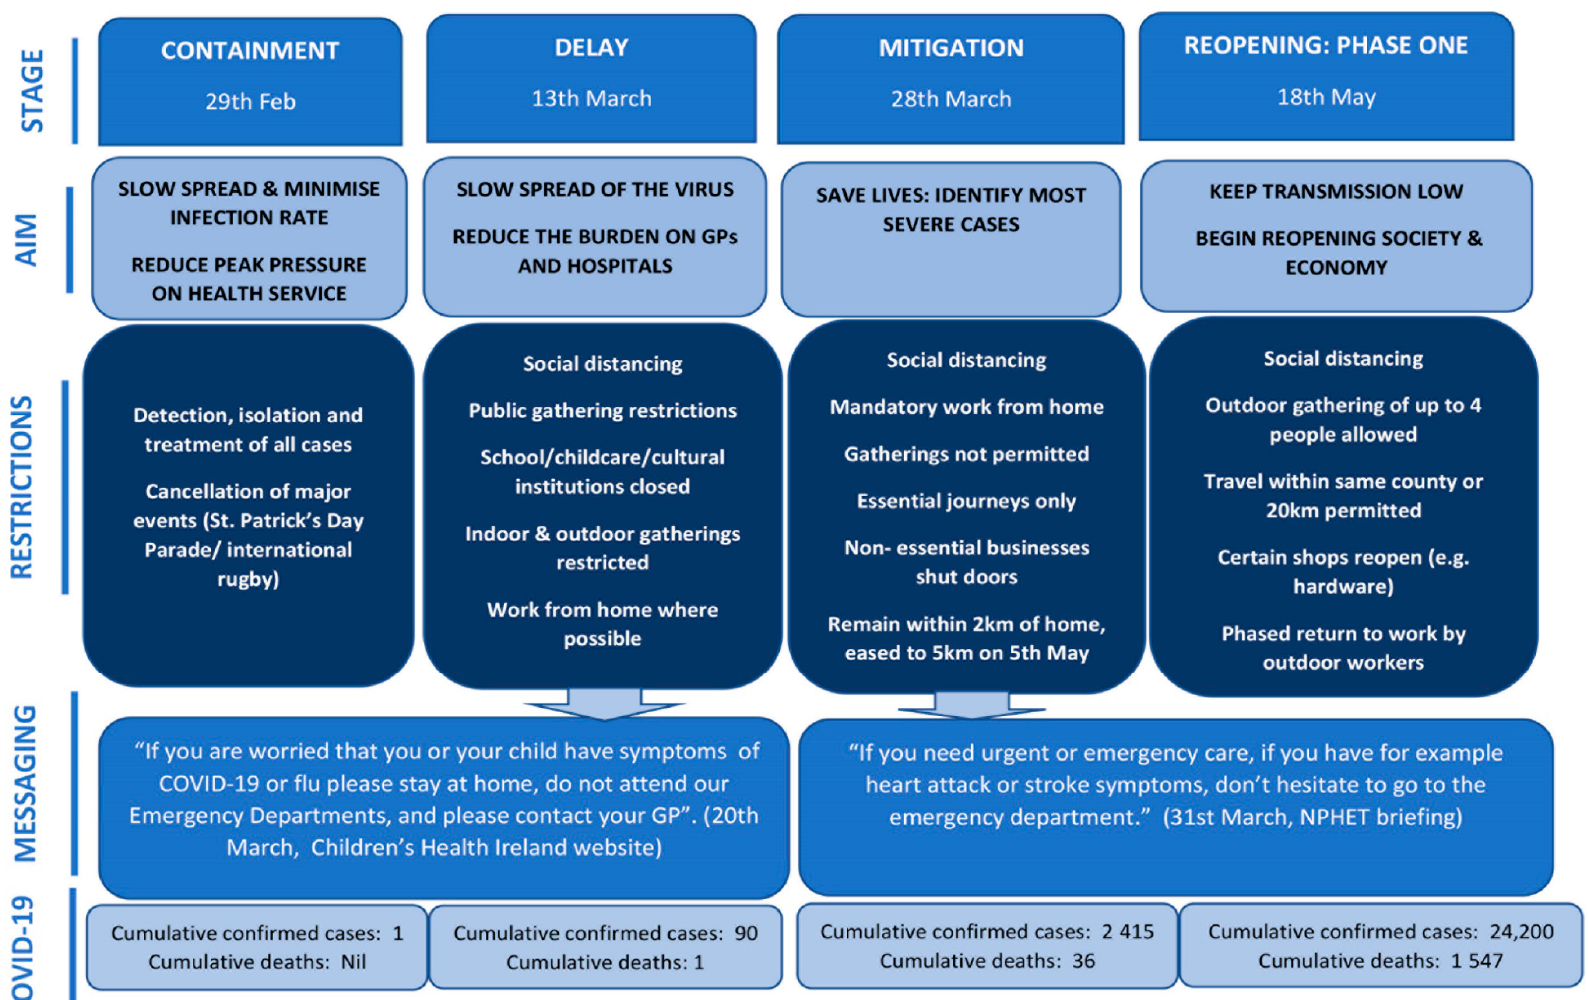
Figure 1. Public health stages of COVID-19 response.